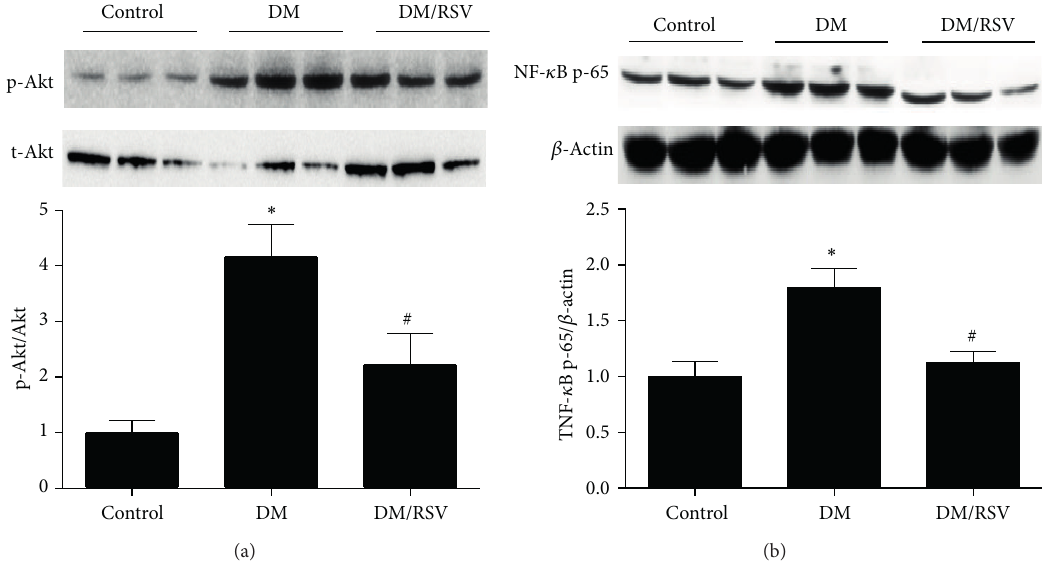
Figure 4: Resveratrol (RSV) downregulated Akt/nuclear factor-kappa B (NF- 𝜅 B) pathway in diabetes mouse kidney. Western blot analysis was carried out to measure the protein levels of Akt, p-Akt (a) and NF- 𝜅 B p65 (b). Results represent as mean ± SD. ∗ 𝑃 < 0.05 compared with control group, # 𝑃 < 0.05 compared with diabetes mellitus (DM) group.